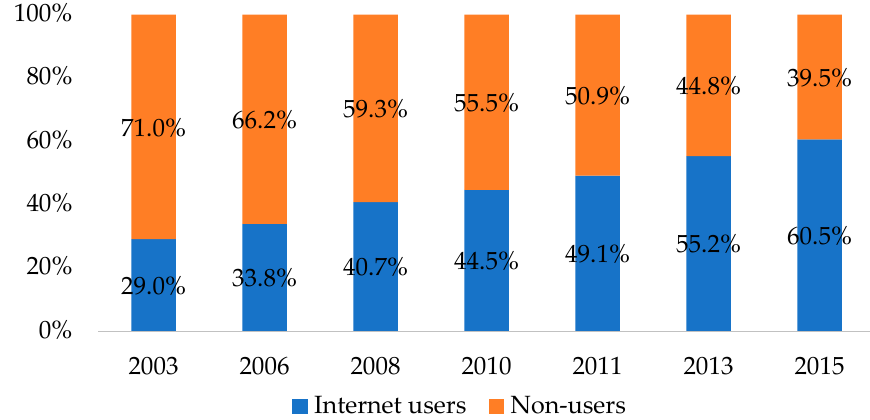
Figure 1. Internet users in relation to non-users. Source: SR2003, SR2006, SR2008, SR2010, SR2011, SR2013, ERC2015. SR2003, n = 2450; SR2006, n = 2000; SR2008, n = 1039; SR2010, n = 1255; SR2011, n = 1250; SR2013, n = 1542; ERC2015, n = 1018.